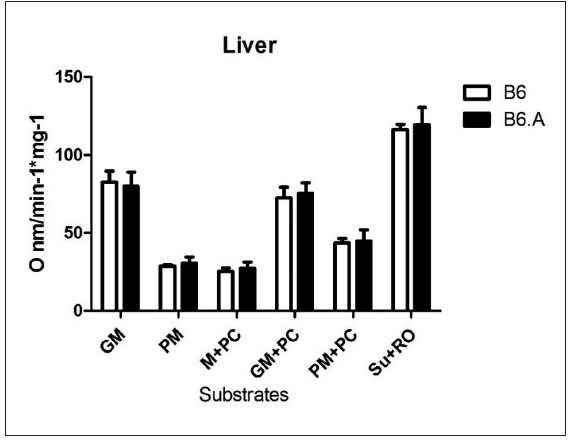
Figure 2. Comparison of three liver mitochondria respiration states between B6 and B6.A mice